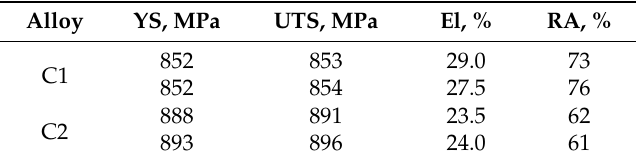
Table 2. Tensile properties of both alloys solution treated at 800 ◦ C for 1 h.